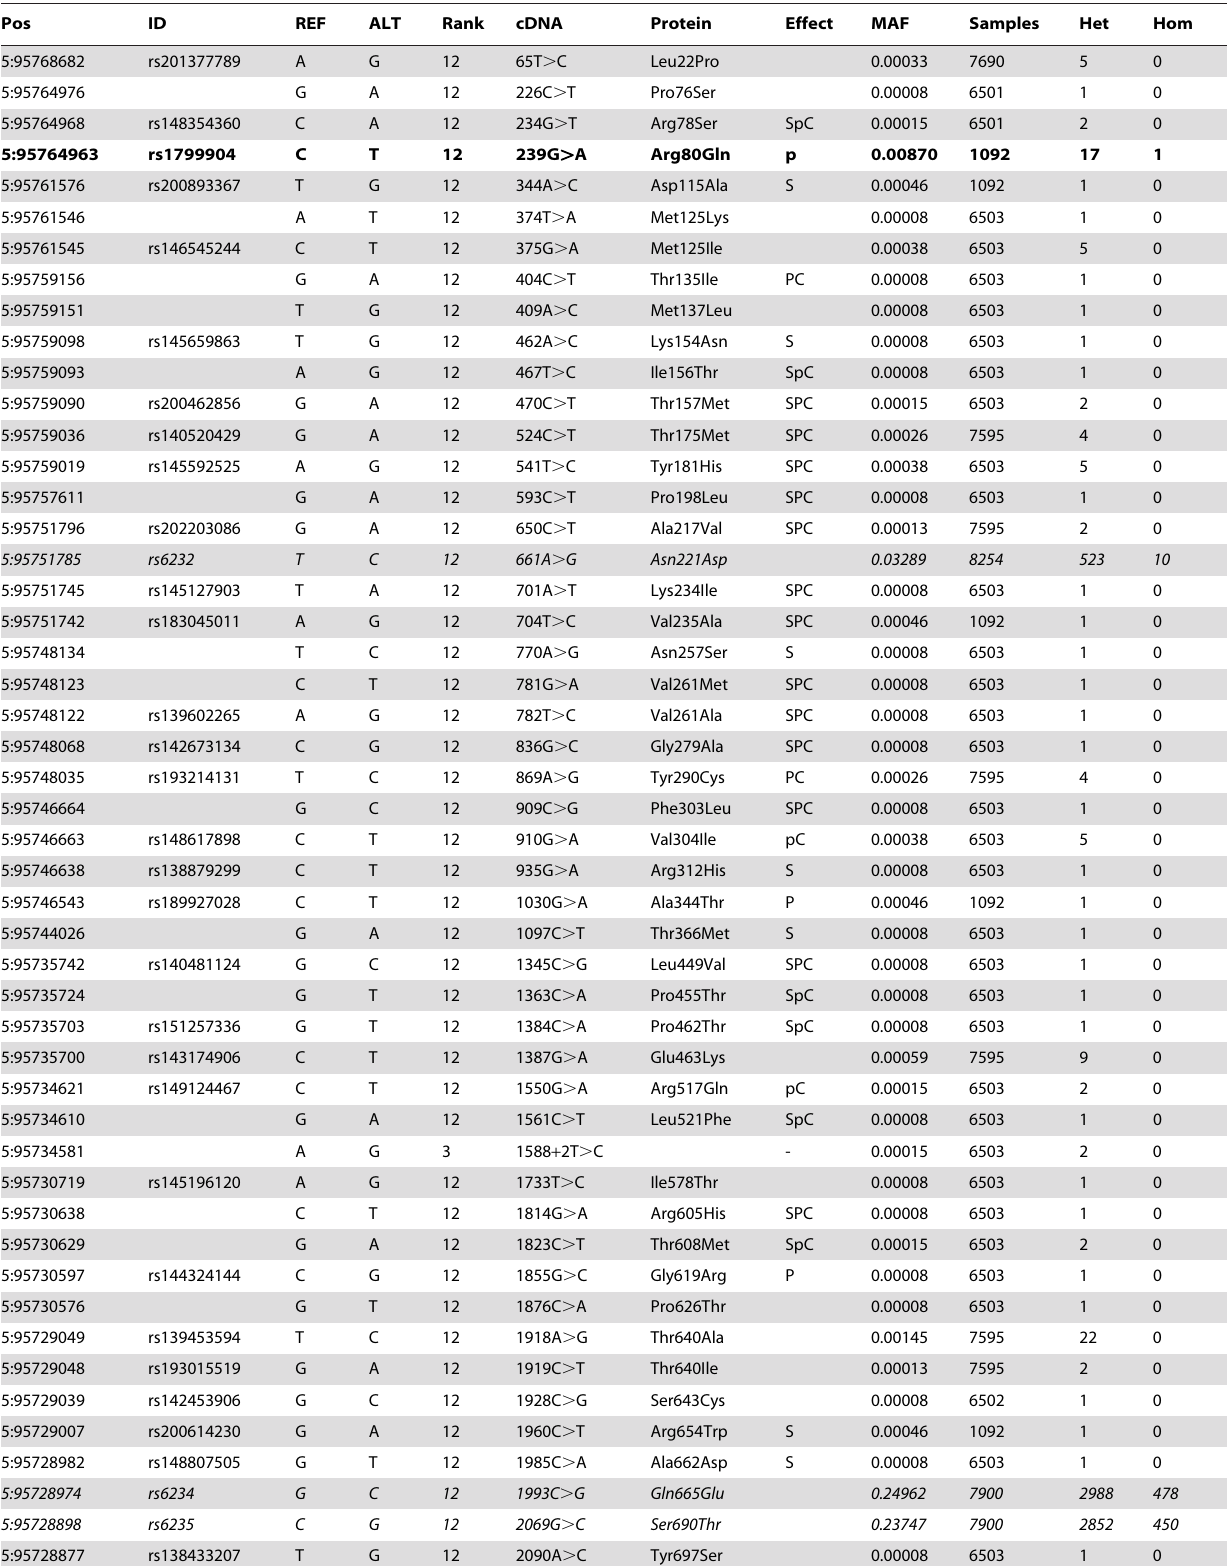
Table 1. Potentially consequential variant alleles in PCSK1 .